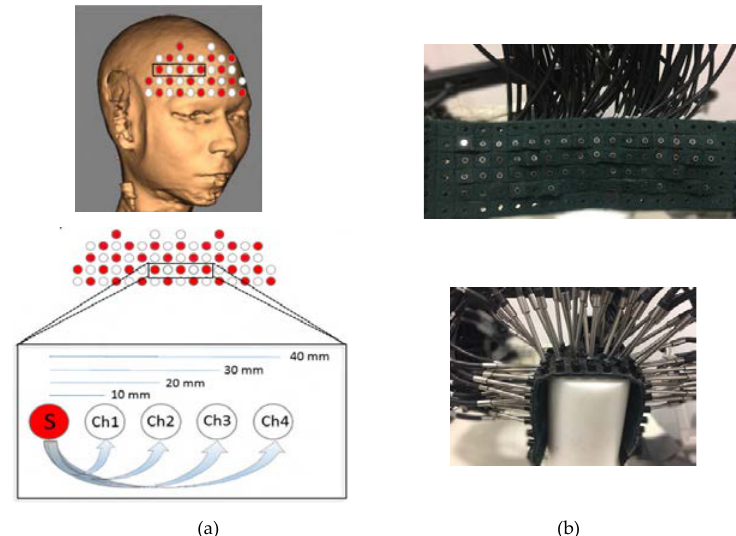
Figure 1. Representation of the optical fibers on the boundary of the frontal cortex in a real space. Definition of nearest neighbor measurements ( a ): The photon trajectory follows a banana path (arrows); therefore, detections at a 10–20 mm distance from the source (S) provide information from extracerebral layers, while detections 30–40 mm from the source also provide information from intracerebral layers. Source-detector pairs are separated by 1 cm in frontal and sagittal views. A total of 64 optical fiber forms the matrix, providing 2048 optical channels thanks to colocalization. Note the rigid structure holding the tip of the optical fibers in place in order to ensure the optical fiber-scalp coupling ( b ).